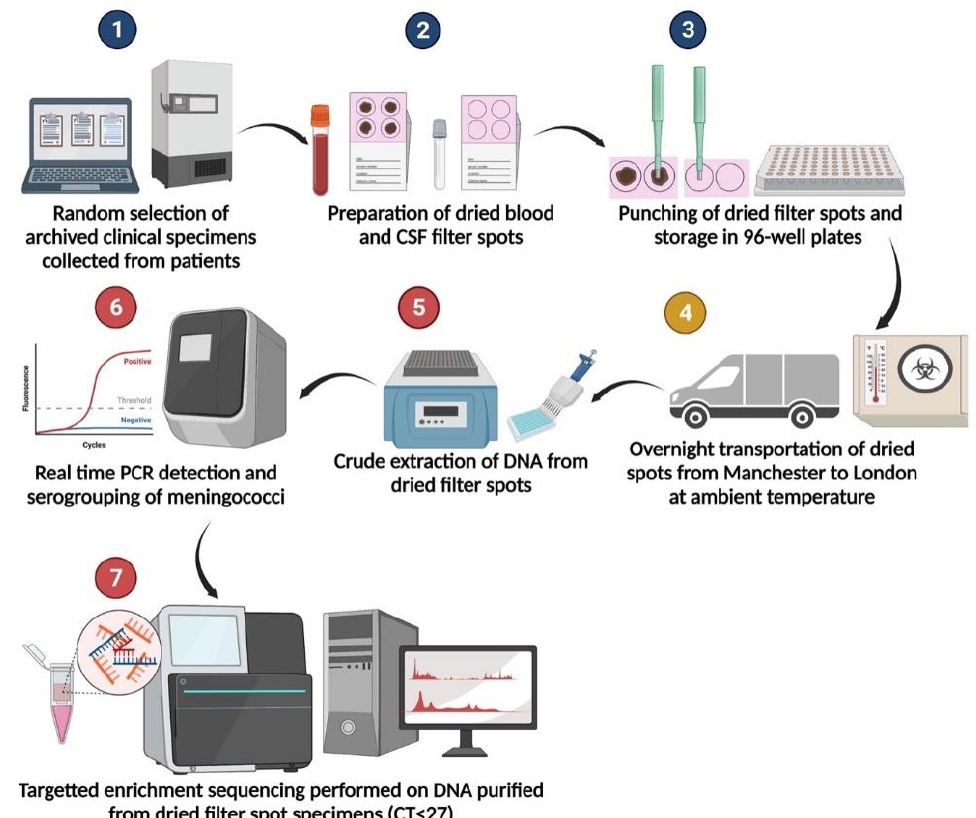
Figure 2. Specimen processing flow diagram. Steps 1 – 3 were performed at the Meningococcal Reference Unit in Manchester. Step 4 indicates shipment via courier by road. Steps 5 – 7 were performed at University College London.